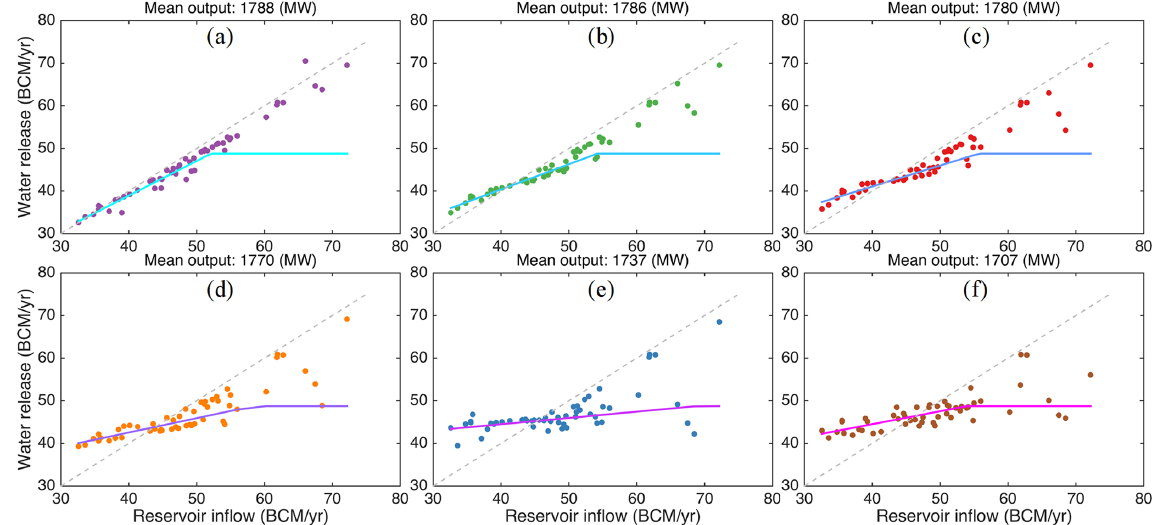
Figure 7. Relationship between annual reservoir inflow and water release (points) and the corresponding drought mitigation policy (lines) for various power generation levels.